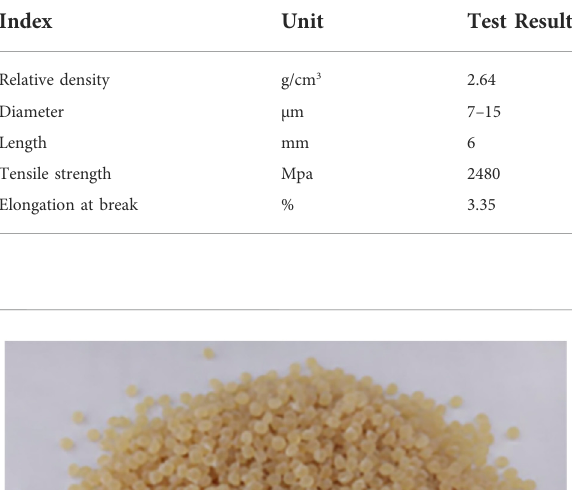
TABLE 2 Technical index of basalt fi ber.